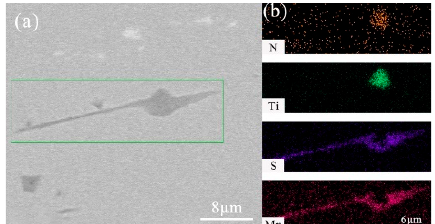
Figure 10. Typical MnS diagrams with TiN as nucleation core ( a ) SEM morphology of inclusions; ( b ) composition distribution of inclusions.